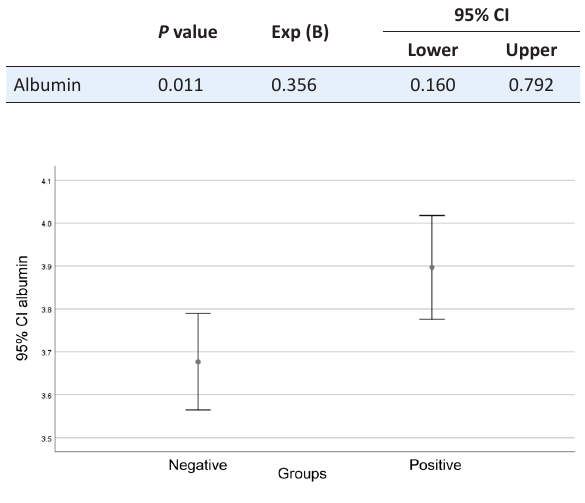
Figure 1. Serum albumin in patients with gram-negative and gram- positive infection of dialysis